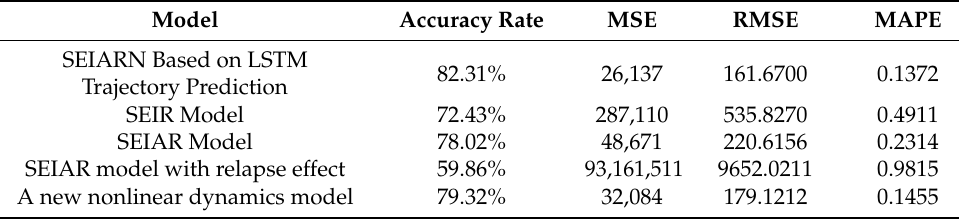
Table 7. Model prediction results of rehabilitation population.